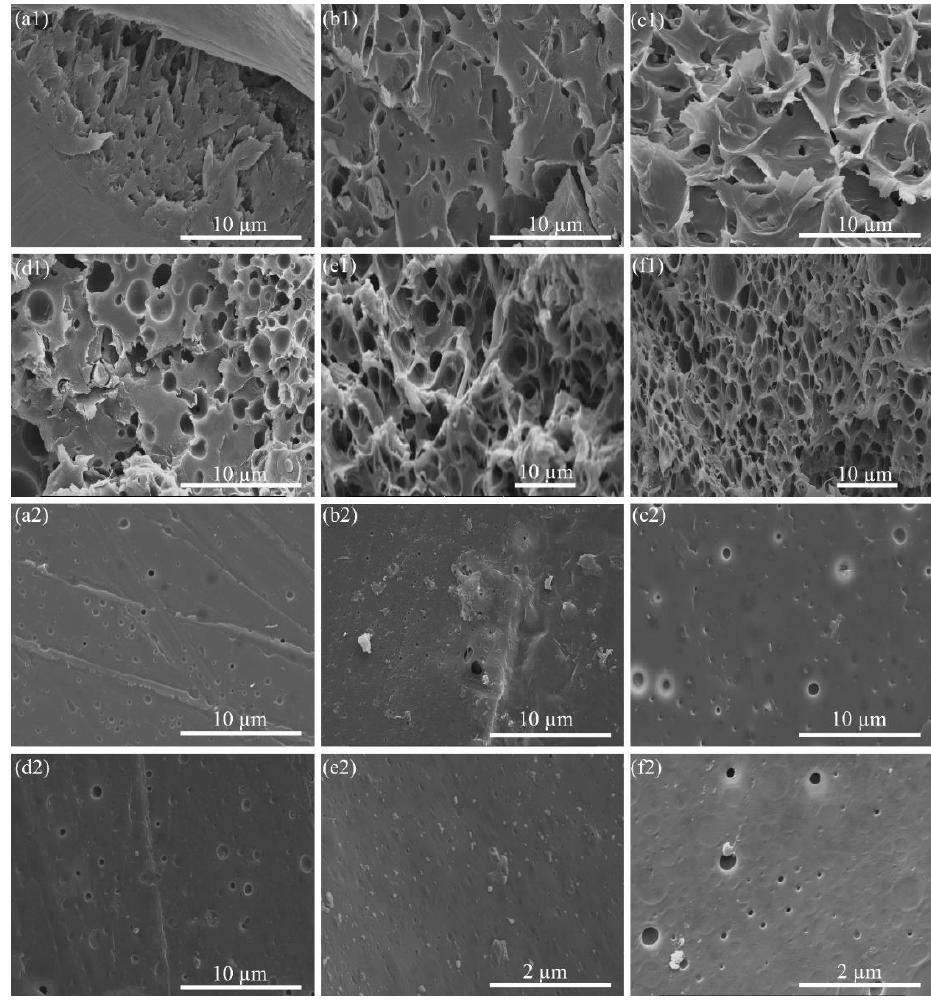
Figure 3. SEM images showing 35 wt. % PS p-LM /PEG of ( a ) 1 wt. %, ( b ) 2 wt. %, ( c ) 3 wt. %, ( d ) 4 wt. %, ( e ) 5 wt. %, and ( f ) 10 wt. % immersed in the water against the flow to dissolve PEG for pore generation. ( a1 – f1 ) Cross-section areas and ( a2 – f2 ) surface areas. Figures S1 and S2 show an enlarged view of ( e2 , f2